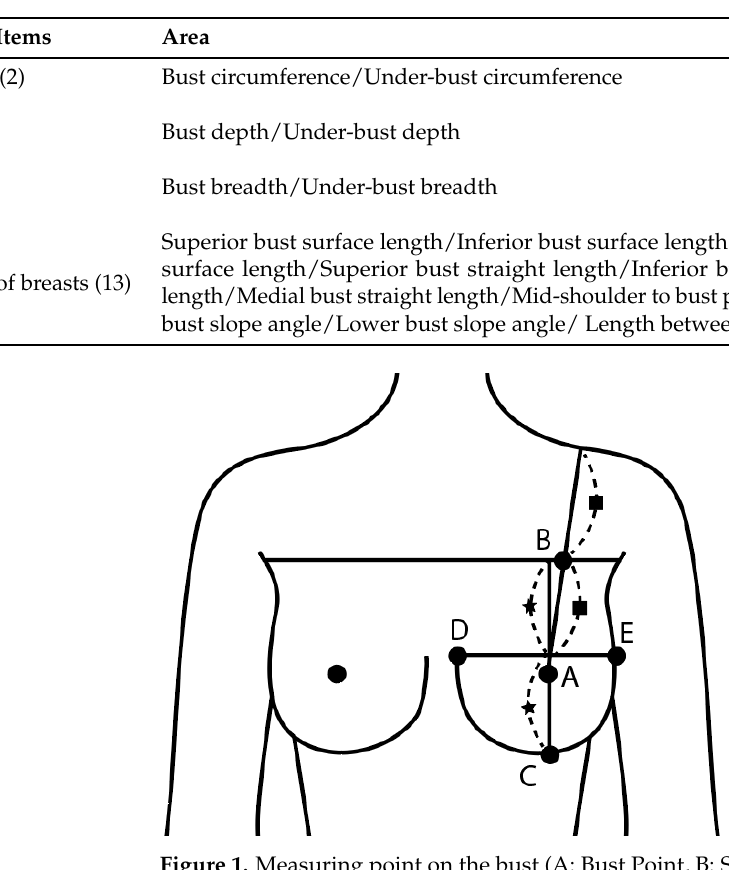
Table 2. Measurement method of breast details.